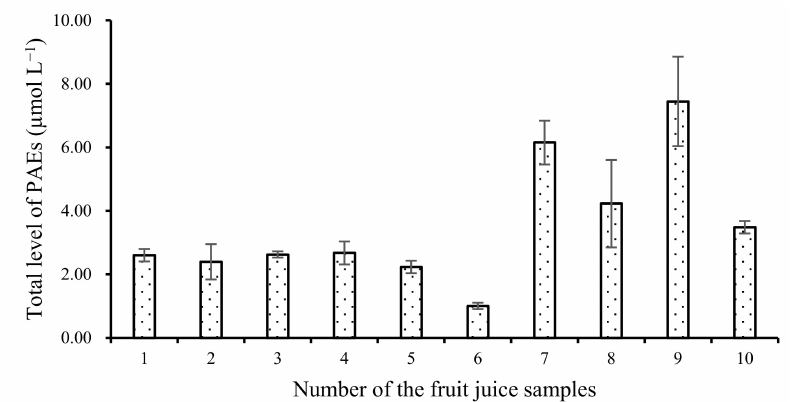
Figure 4. Total level of PAEs in each fruit juice sample in plastic